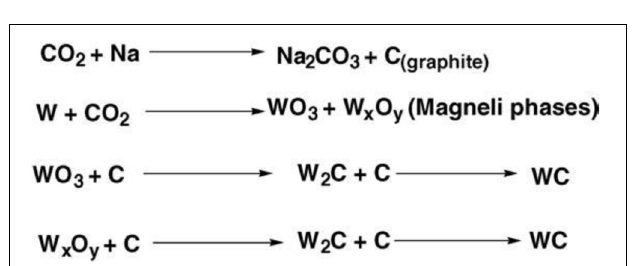
FIGURE 7 | Reaction scheme of the CO 2 heat treatment method (Wang et al., 2006) [Scheme 1 of Wang et al. (2006), Copyright Elsevier B.V.].